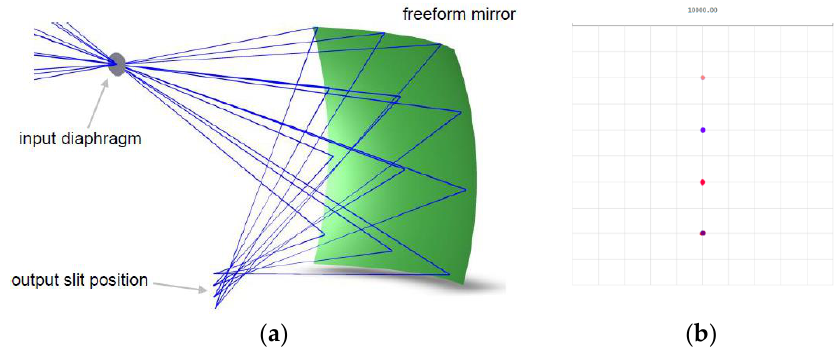
Figure 9. ( a ) Screenshot of the Optic Studio implementation using 3D visualization. ( b ) Spot diagram.